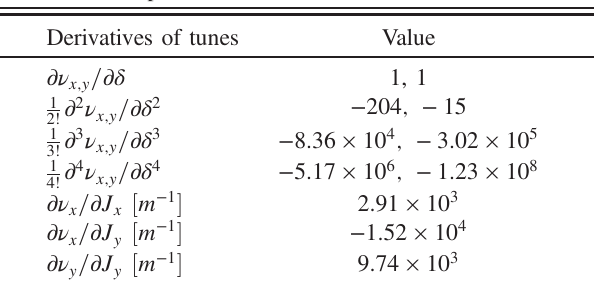
TABLE II. Normal form analysis in the ring with two global families of sextupoles.